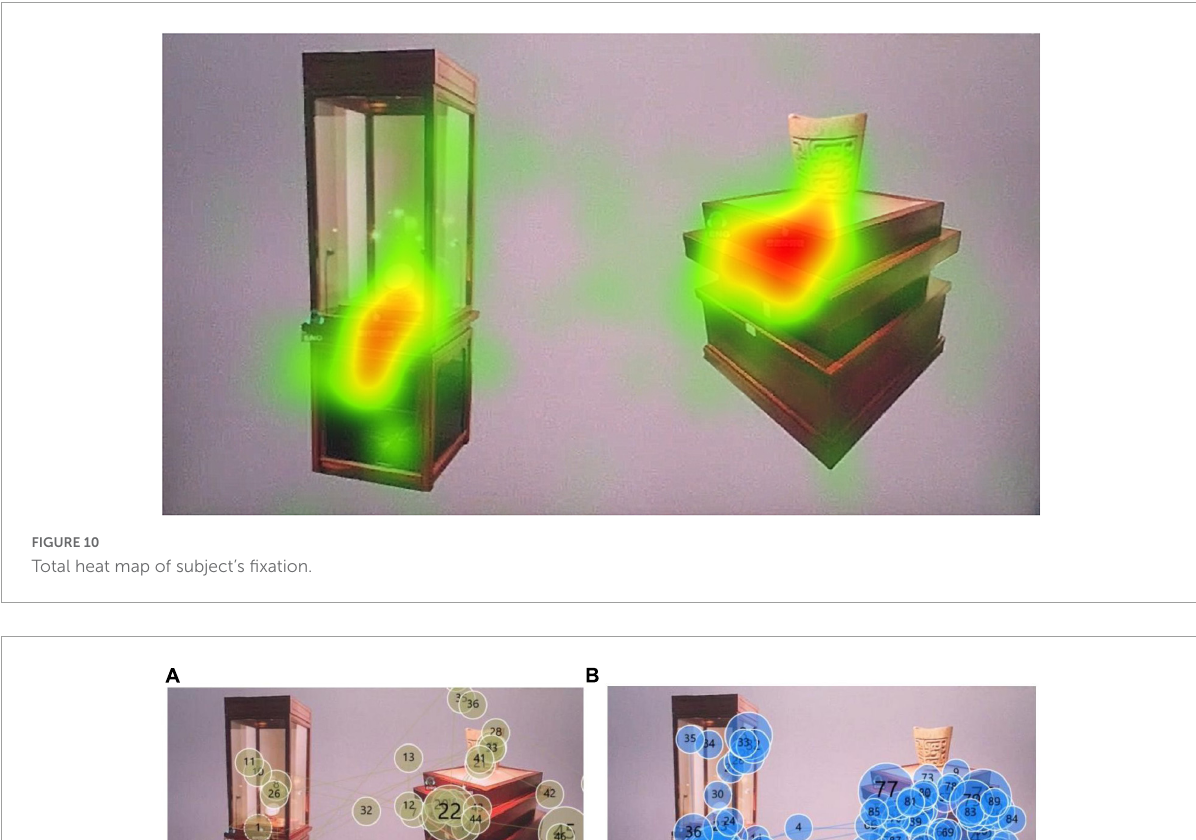
FIGURE11 Subject’s gaze trajectory: (A) subject 2’s gaze trajectory; (B) subject 3’s gaze